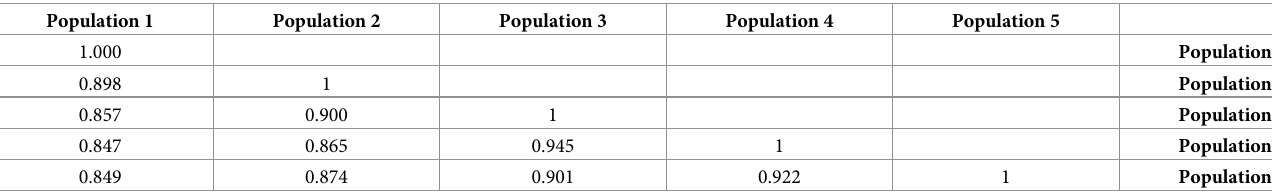
Table 5. Pairwise population matrix of Nei’s unbiased genetic